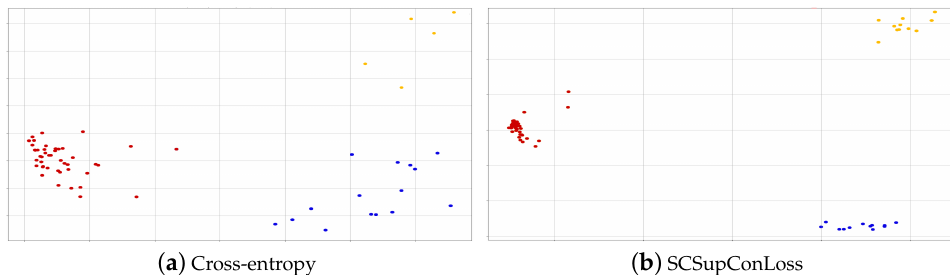
Figure 3. Loss function clustering visualization. In supervised comparative learning, clustering can be accomplished by embedding samples into low-dimensional embedding spaces and then using clustering algorithms to divide the samples in the embedding space into different clusters. The red, blue, and yellow dots in the embedding space represent the aggregation of different classes of samples, and we can see how our model loss function outperforms the cross-entropy loss